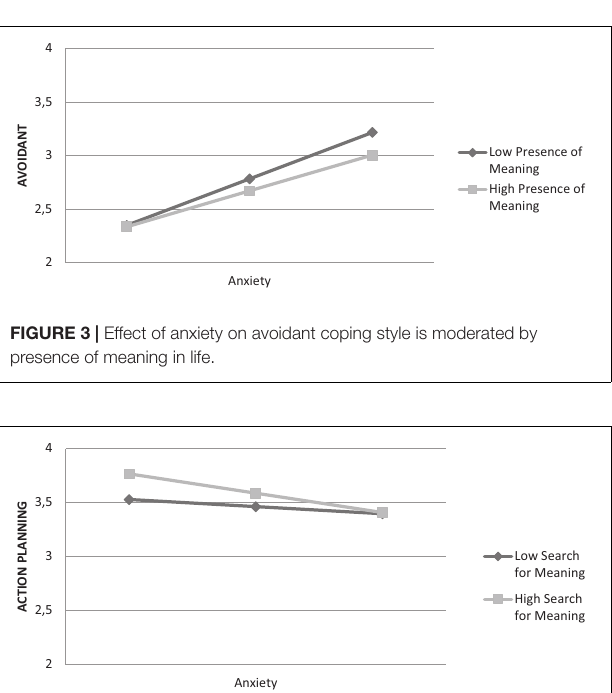
significant ( p = 0.070), whereas the effect of search for meaning slightly decreased but was maintained: β = –0.06, t (848) = –1.96, p =